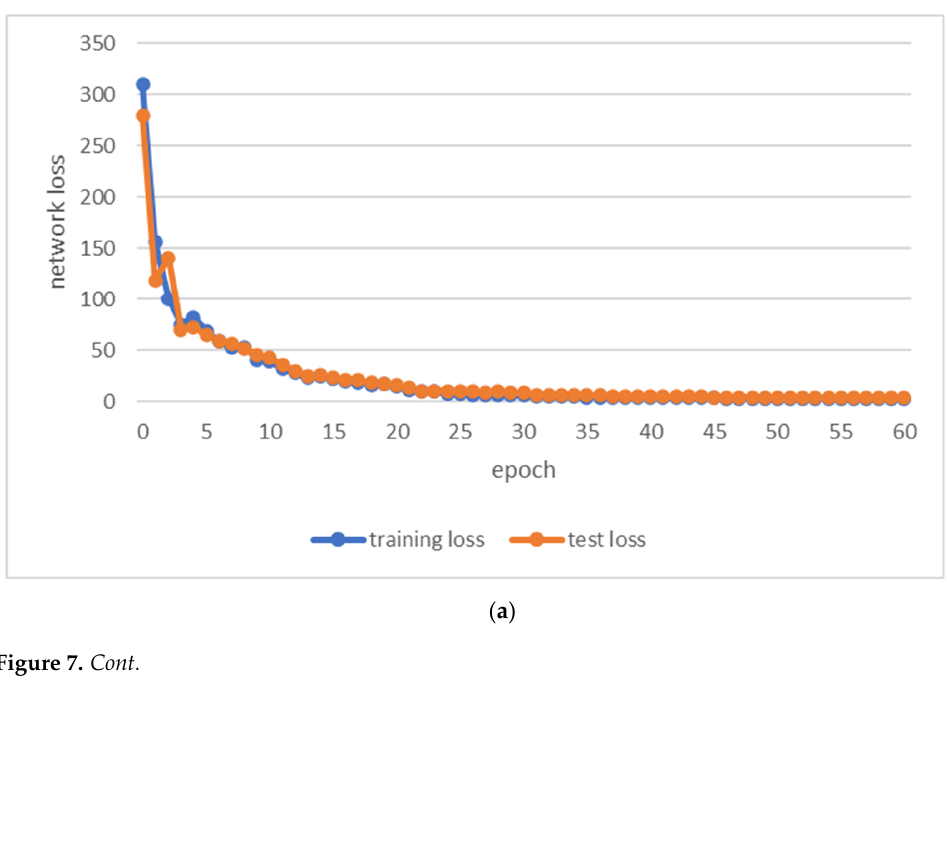
Figure 6. Schematic of the experimental setup.